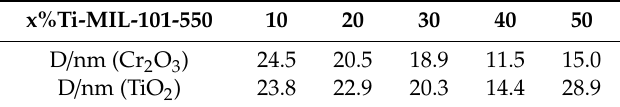
Figure 2. Nitrogen adsorption isotherms of various samples.